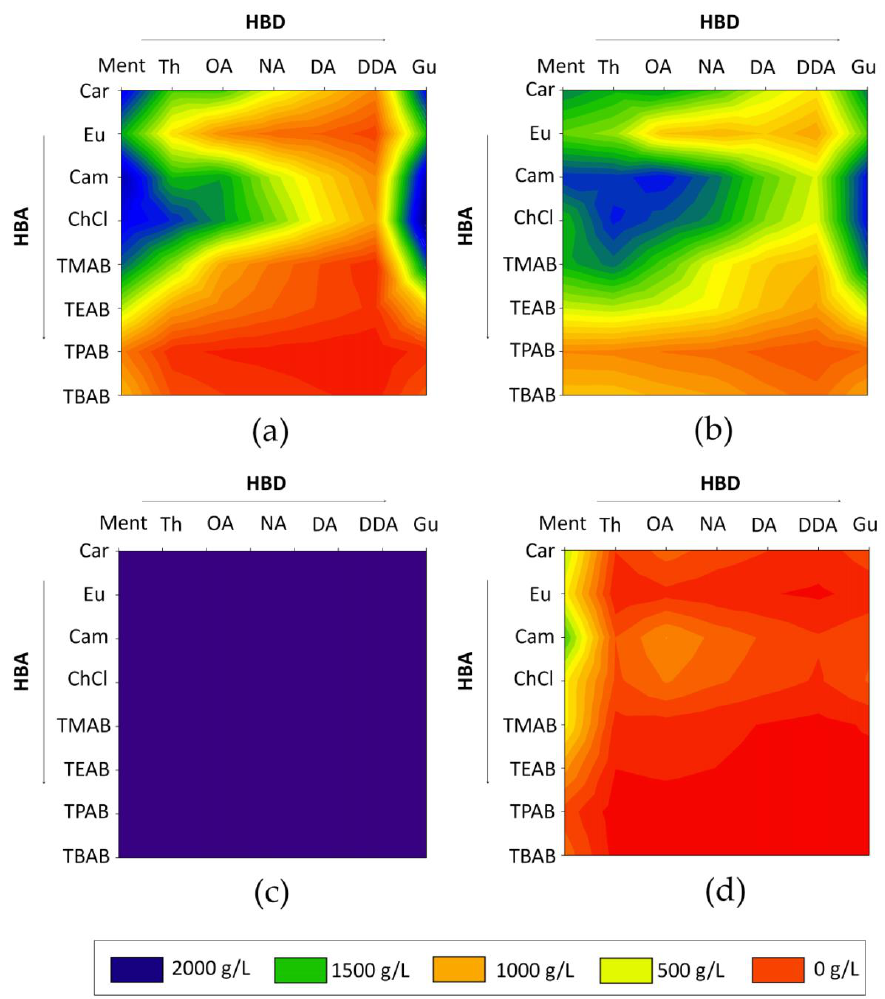
Figure 3. Relative solubility of the ( a ) LA; ( b ) HMF; ( c ) FF; ( d ) water in 56 deep eutectic solvent complexes predicted by COSMO-RS.